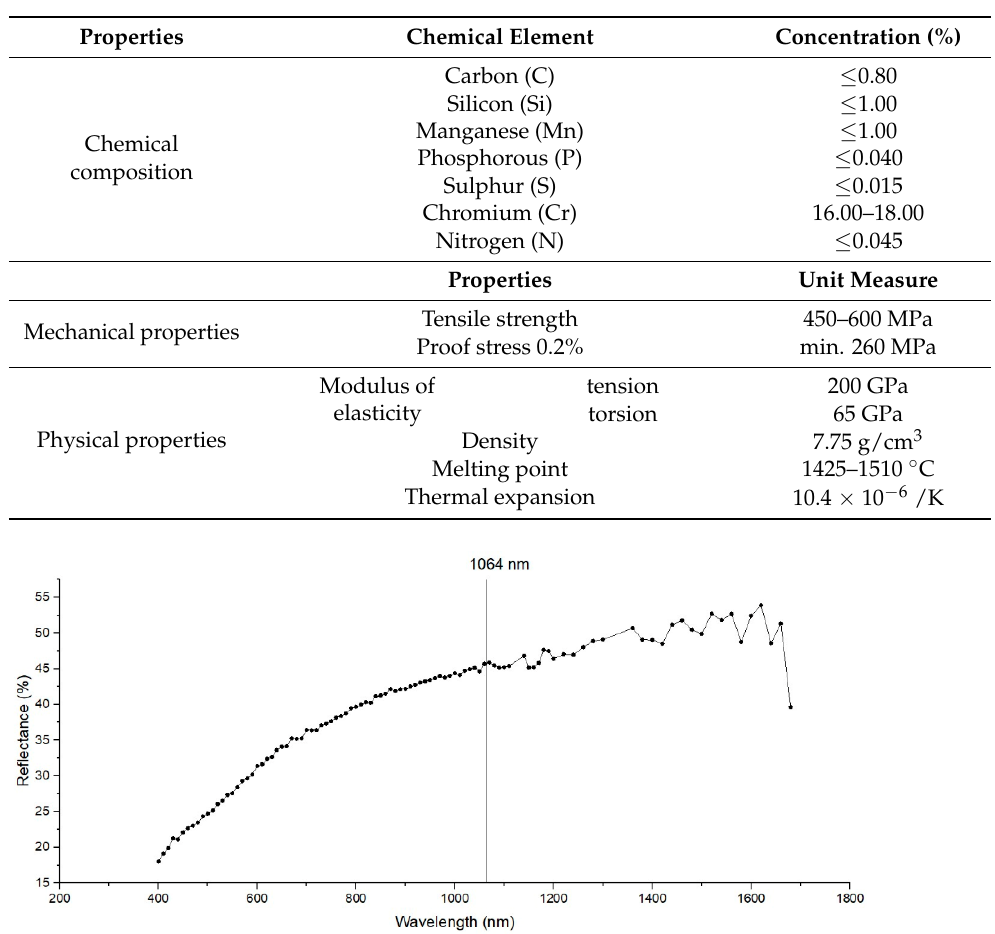
Table 1. Chemical composition, mechanical and physical properties of AISI 430 stainless steel, according to ASTM A-240 and EN 10088-2:2005.